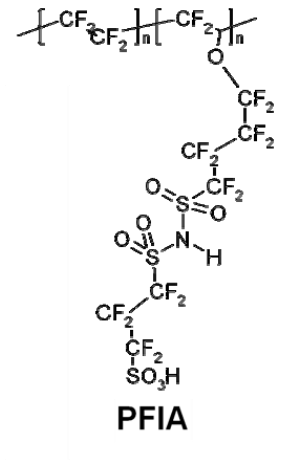
Figure 3. Structure of the 3M low EW perfluoroimide acid (PFIA)